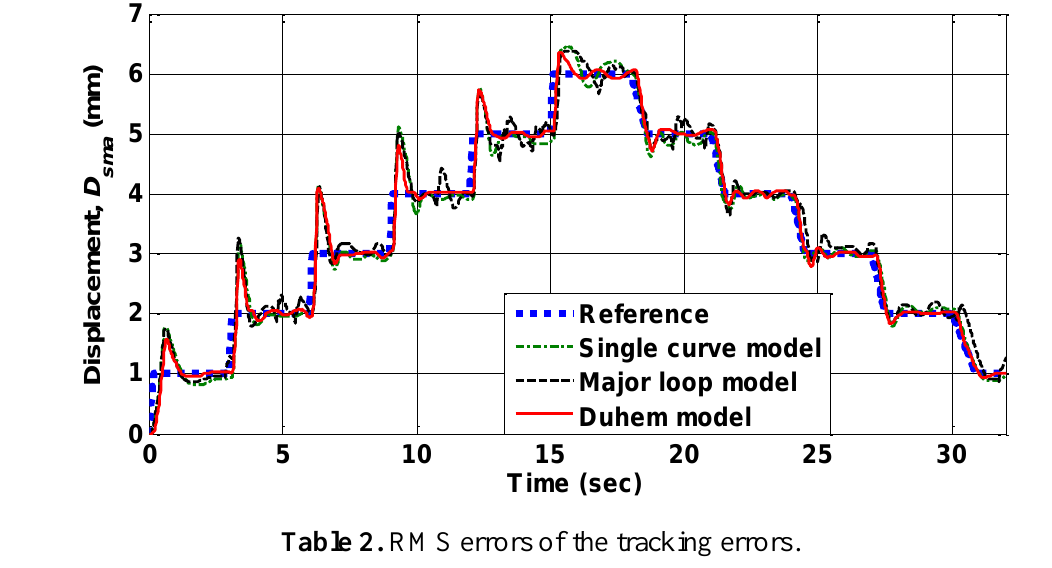
Figure 15. PID control with different self-sensing models: the single curve model (dash-dotted line), the major loop model (dashed line), and the Duhem model (solid line).